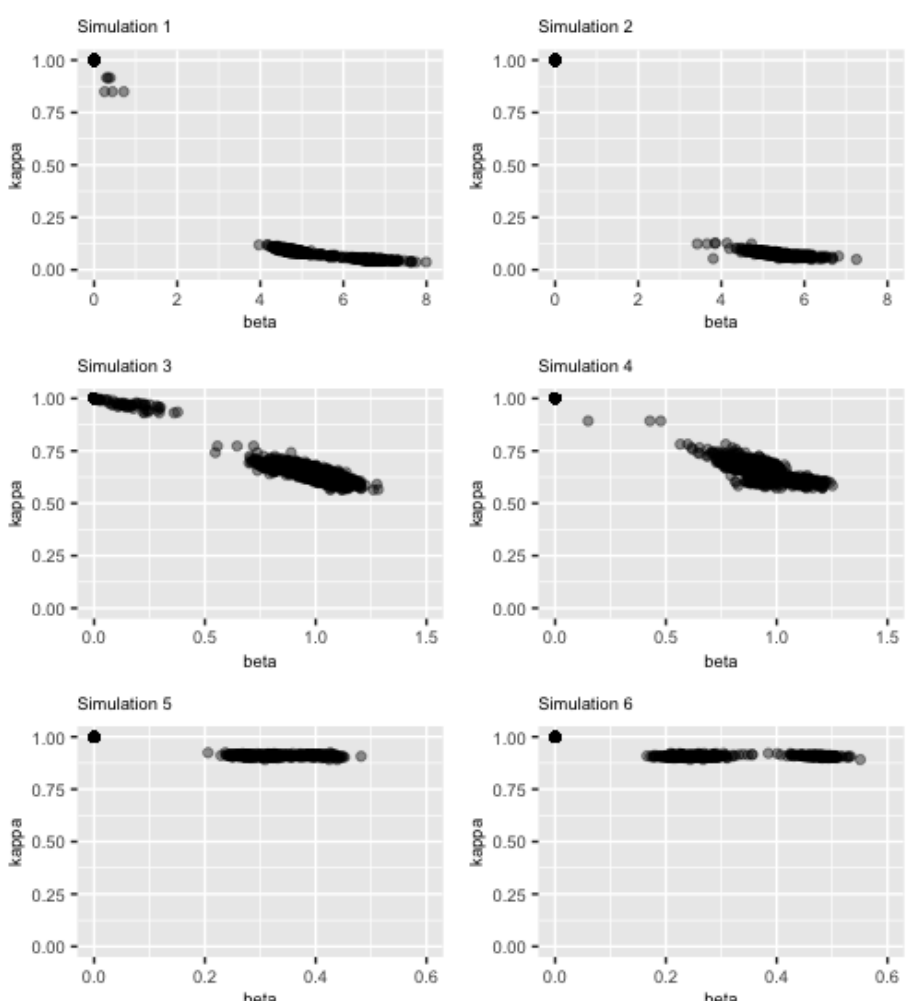
Figure 4. Scatter splots of shrinkage profile estimations ˆ κ ij (y-axis) versus ˆ˜ β ij (x-axis) from 180 nowcast estimates. Each subplot represents the result for each